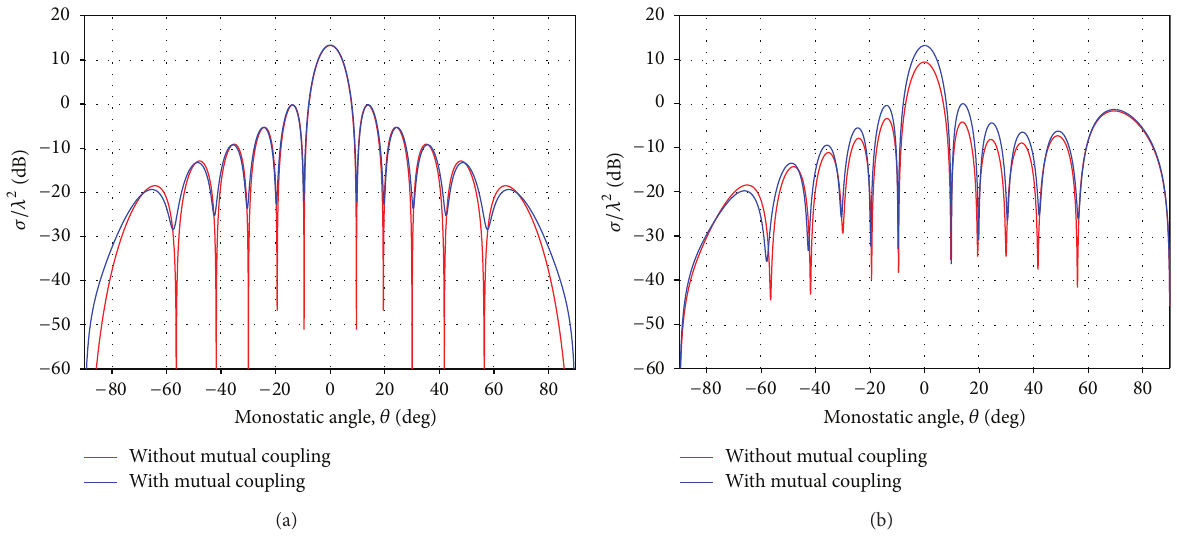
Figure 10: Effect of mutual coupling on RCS of series-fed linear parallel-in-echelon dipole array of 𝑁 = 30 , 𝜓 = 𝜋/2 , 𝑑 = 0.1𝜆 , 𝑙 = 0.5𝜆 , = 125 Ω , and 𝑍 = 235 Ω ; unit amplitude uniform distribution. (a) 𝜃 𝑎 = 10 −5 𝜆 , 𝑍 0 𝑙